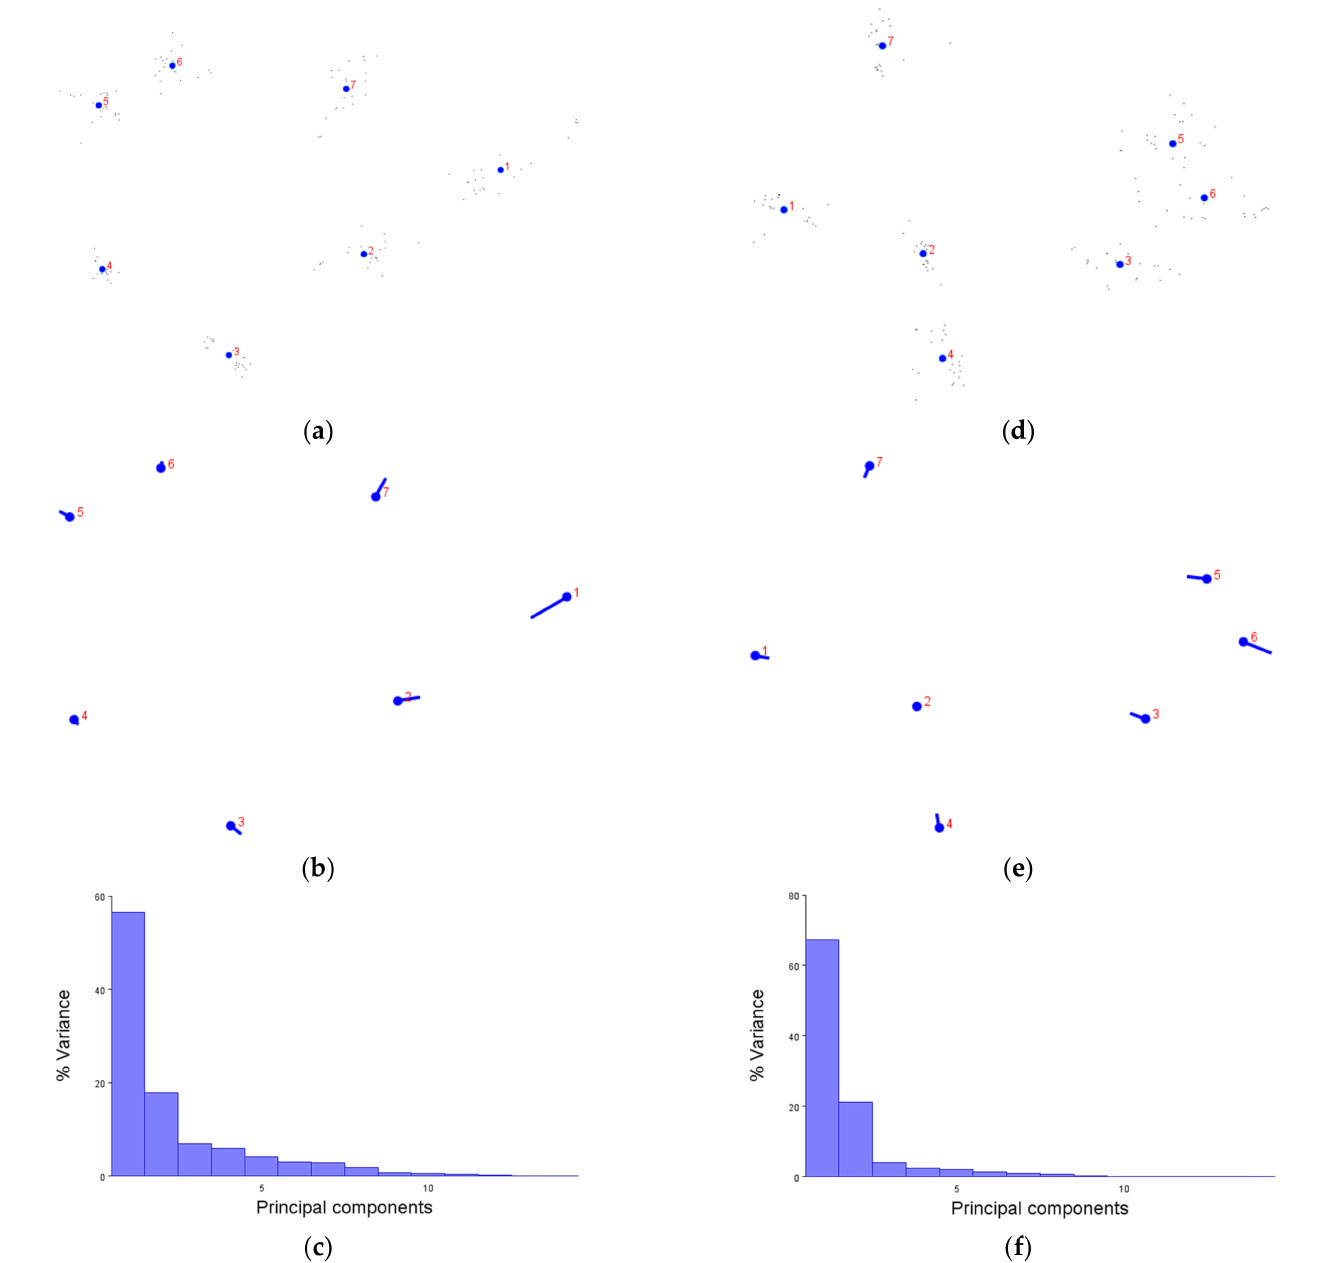
Figure A3. Supplementary graphs to support Figure 5. ( a ) Generalised Procrustese transformation, ( b ) PC1 variation and ( c ) eigenvalues for the extracellular face of the orexin receptors. ( d ) Generalised Procrustese transformation, ( e ) PC1 variation and ( f ) eigenvalues for the intracellular face of the orexin